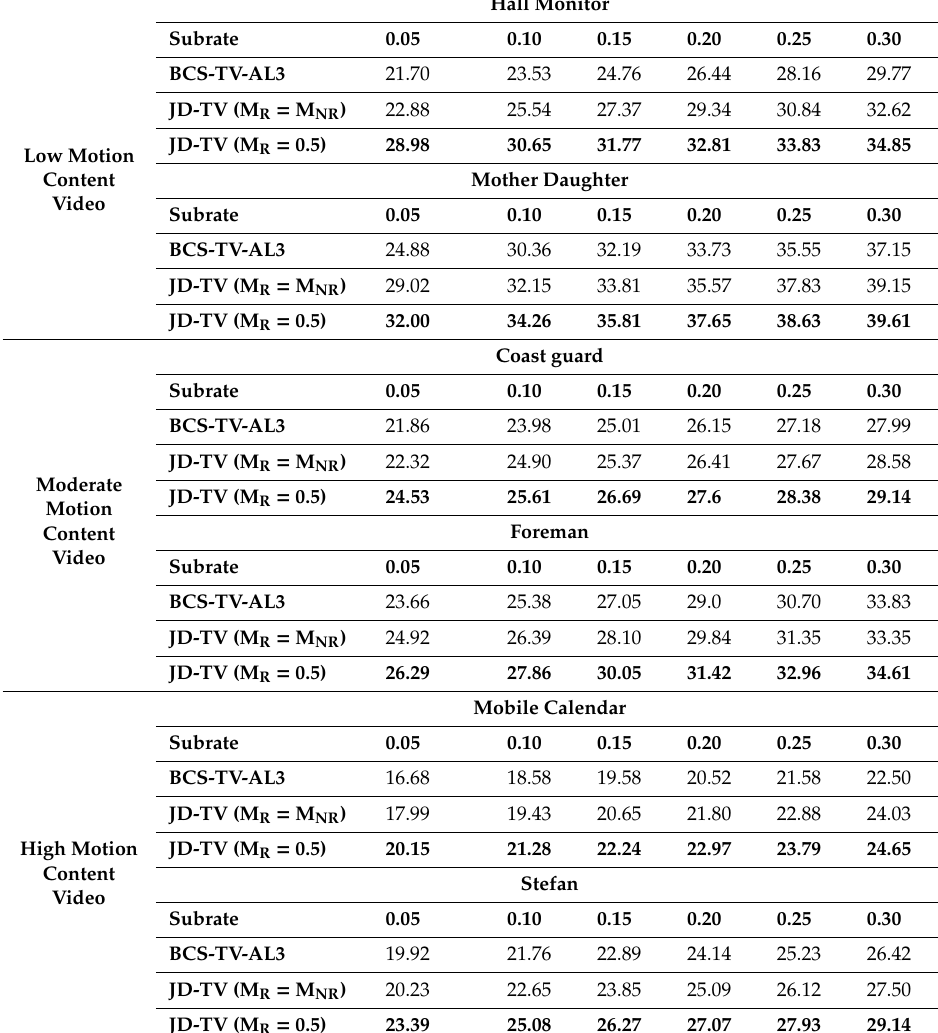
Table 4. Average PNSR evaluation of proposed JD-TV scheme and the independent BCS-TV-AL3 for di ff erent low, moderate and high motion content video sequences at GoP =